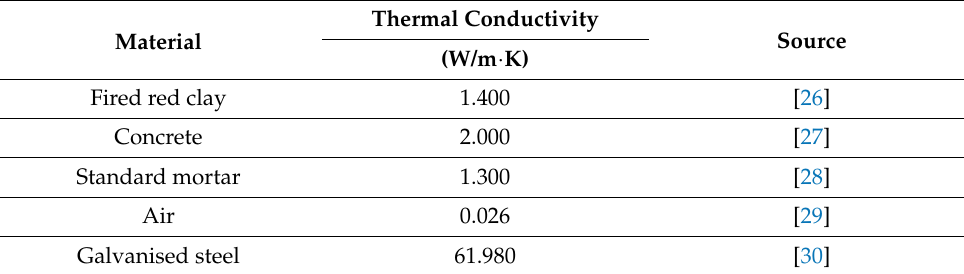
Table 1. Thermal conductivities of the different phases in FE models.